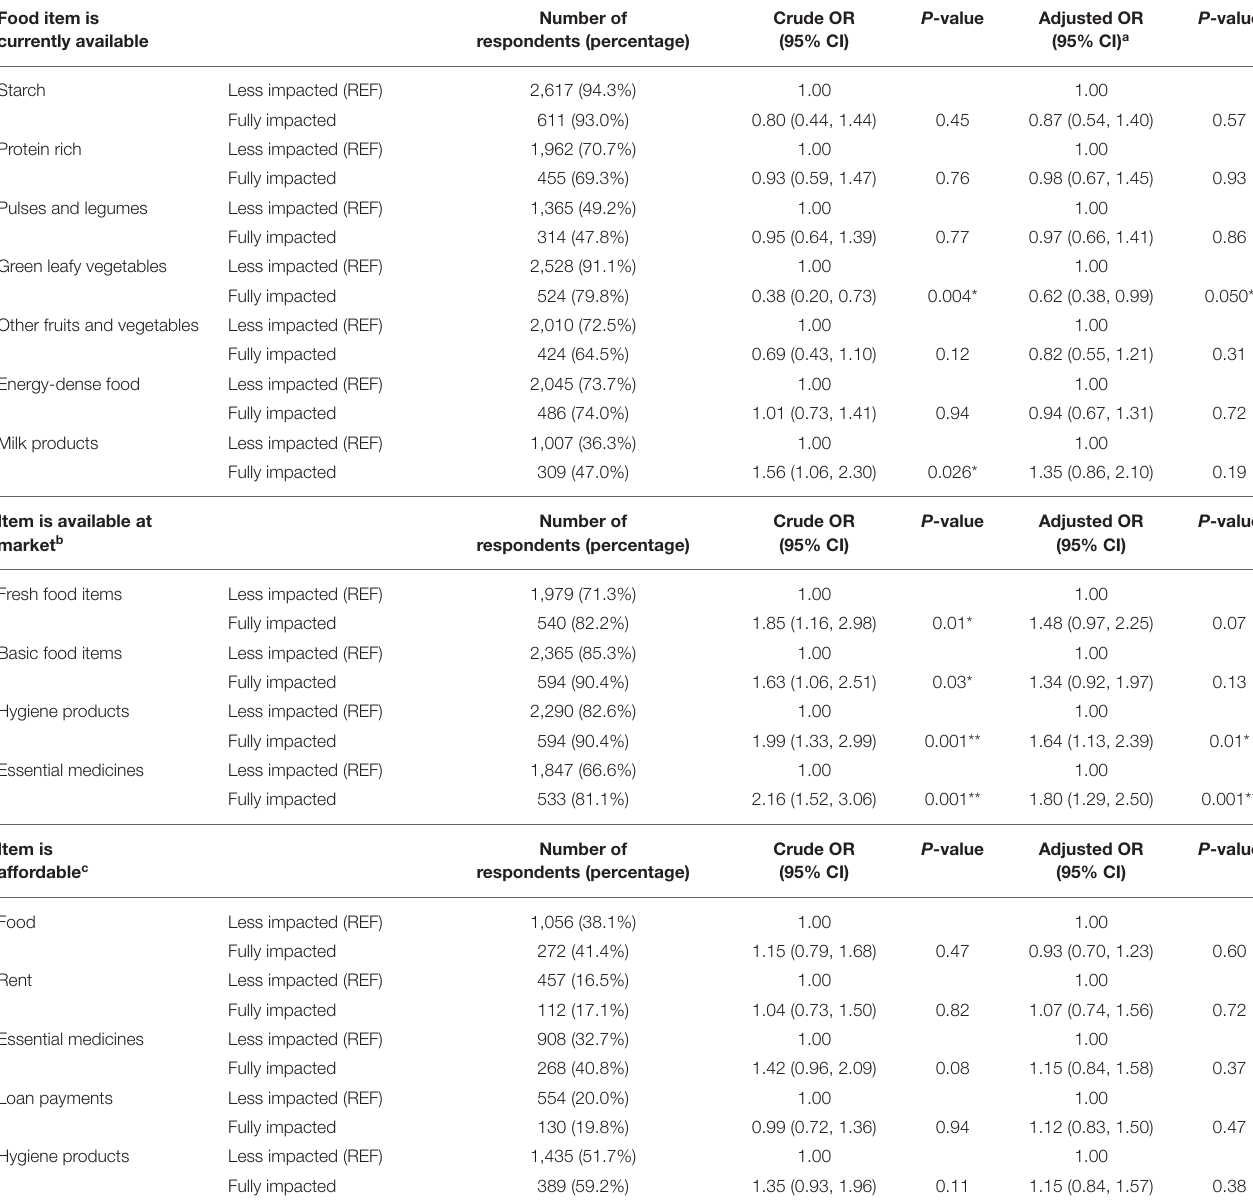
TABLE 3 | Accessibility, affordability, and availability of items by livelihood impact group. Food item is currently